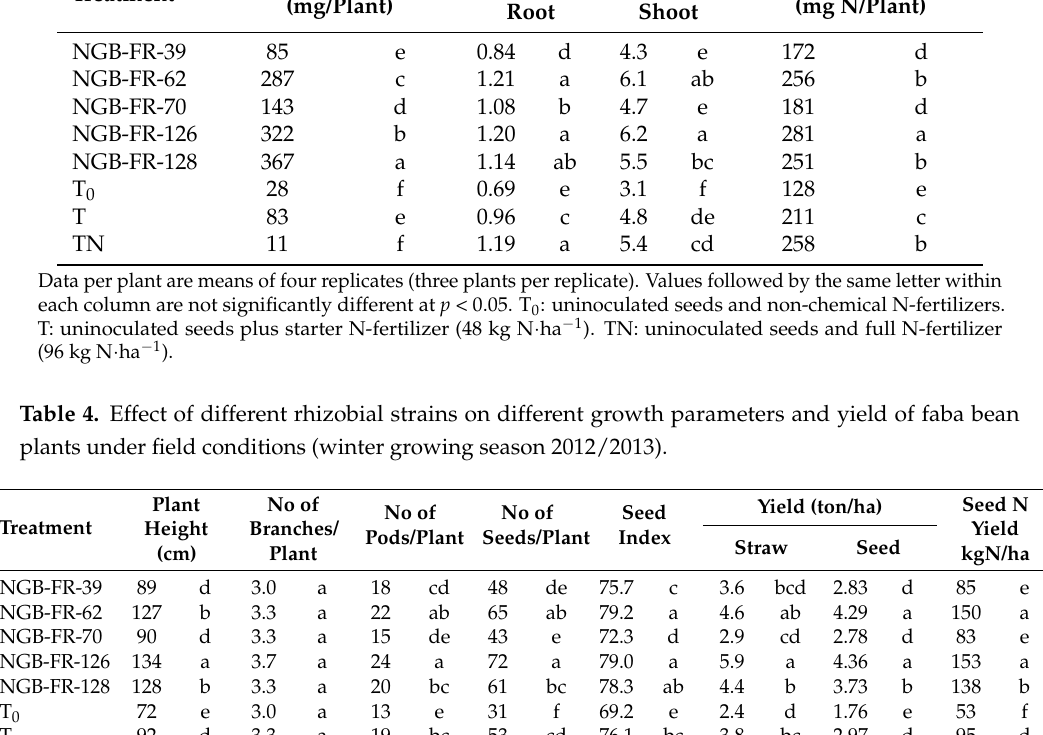
Table 3. Effect of different rhizobial strains on nodulation, growth parameters, and shoot N content of faba bean plants after 50 days of sowing under field conditions (winter growing season 2012/2013). Dry wt. (g/Plant) Shoot N Content Dry wt. of Nodules Treatment (mg N/Plant)Root Shoot (mg/Plant)